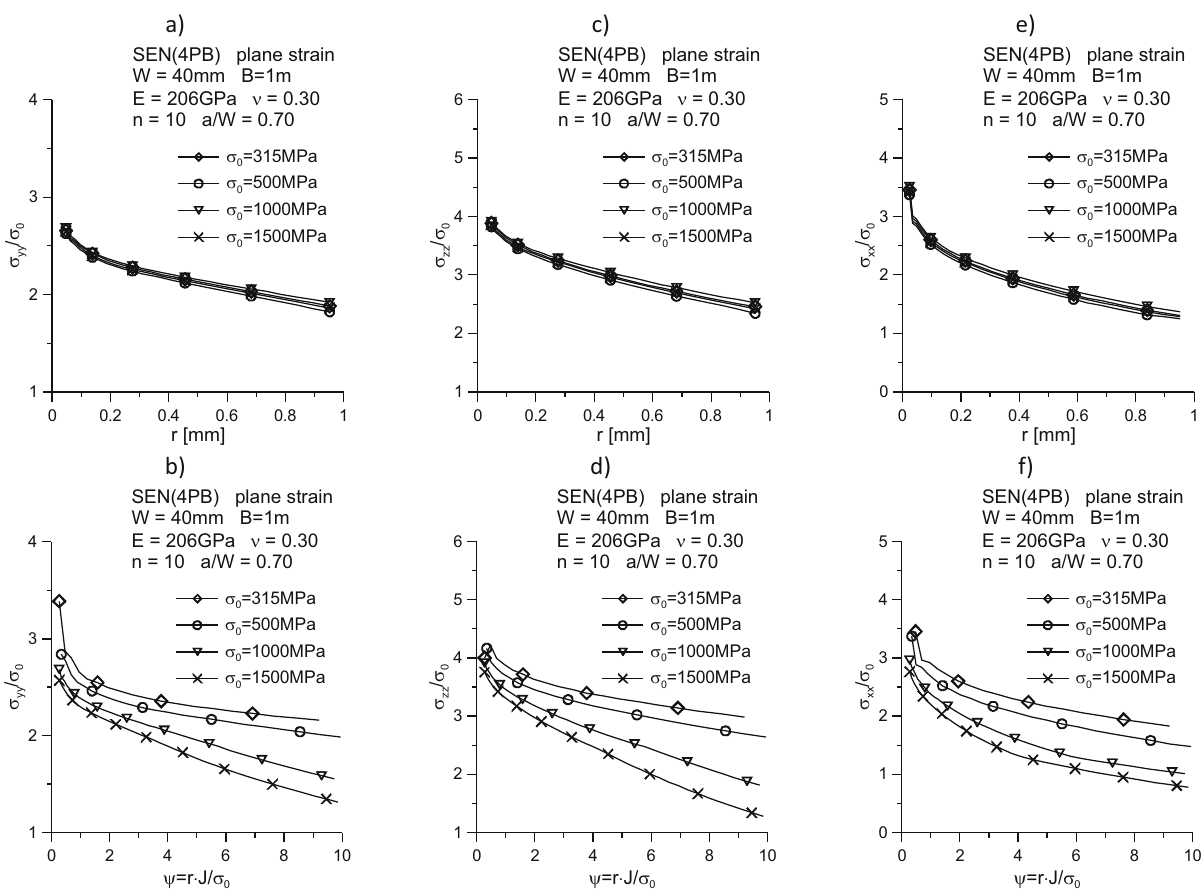
Figure 23: In fl uence of the yield point σ 0 on the distribution of the main stress tensor components: components in the plane of crack propagation σ yy / σ 0 ( a and b ) and σ zz / σ 0 ( c and d ) and the component in the thickness direction ( along the crack front ) σ xx / σ 0 ( e and f ) , near the crack tip ( graphs ( a, c, and e ) were prepared for the physical distance from the crack tip; graphs ( b, d, and f ) were prepared for the normalized distance from the crack tip ψ = r · J / σ 0 ; the charts are presented for the moment when the external load reaches the limit load value – P / P 0 = 1.00; with the following J integral values for subsequent specimens: σ 0 = 315 MPa, J = 15.6 kN/m; σ 0 = 500 MPa, J = 34.3 kN/m; σ = 1,000 MPa, J = 175.3 kN/m; σ = 1,500 MPa, J = 336.2 kN/m ) 0 0